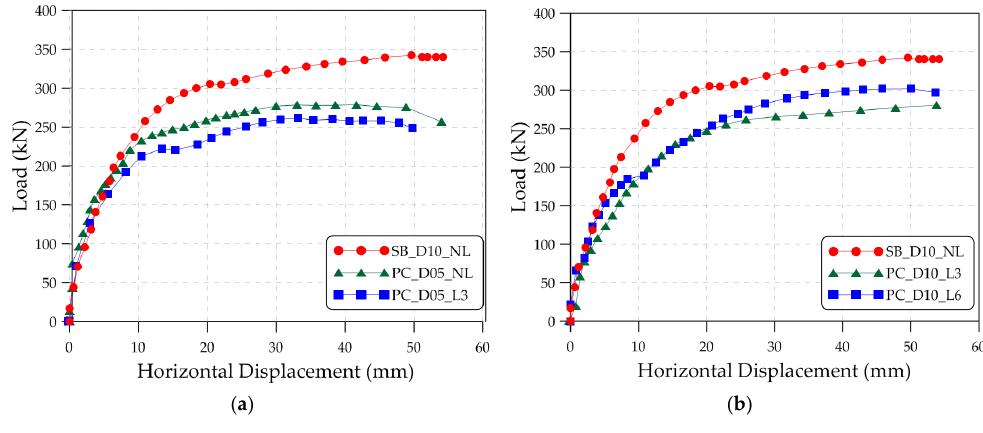
Figure 11. Effect of the number of L ‐ shaped plates. ( a ) PC_D05 specimens. ( b ) PC_D10 specimens. Table 8. Effect of the number of L ‐ shaped plates for PC_D05 specimens.